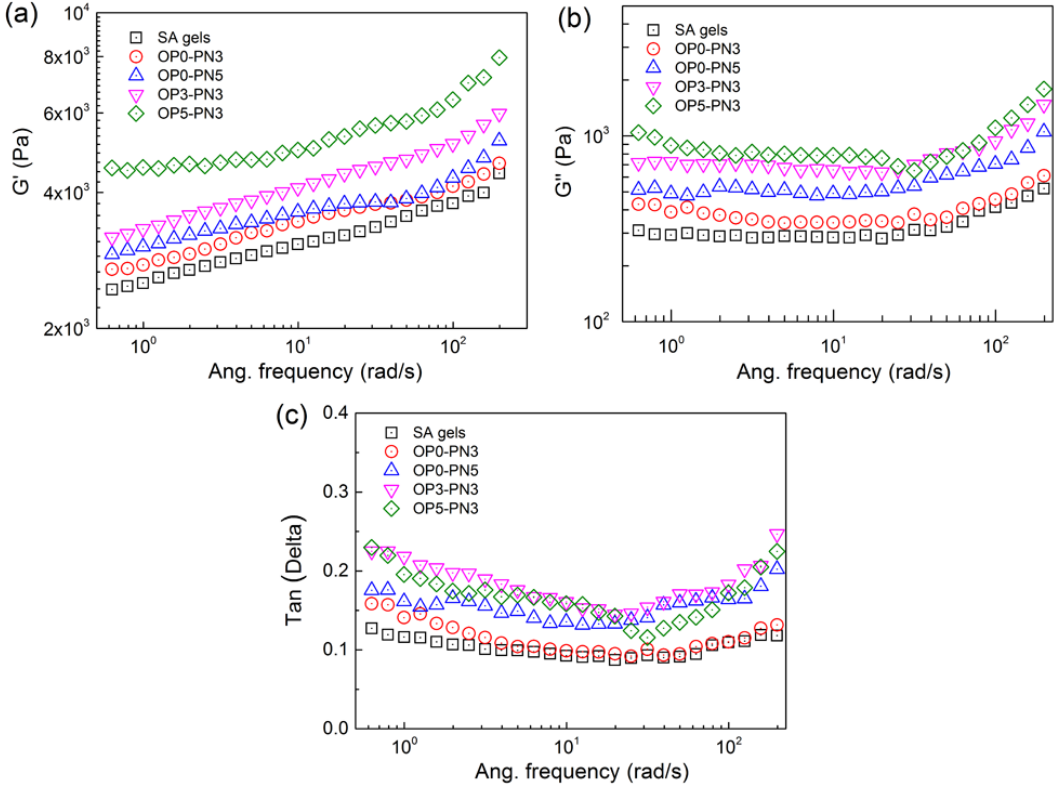
Figure 4. Rheological behavior of SA and OPn-PNm gels measured under a dynamic frequency sweep at fixed strain, γ = 1%, which is in linear viscoelastic region LVE. ( a , b ) G’ and G” of gels; ( c ) tan(Delta) of gels.